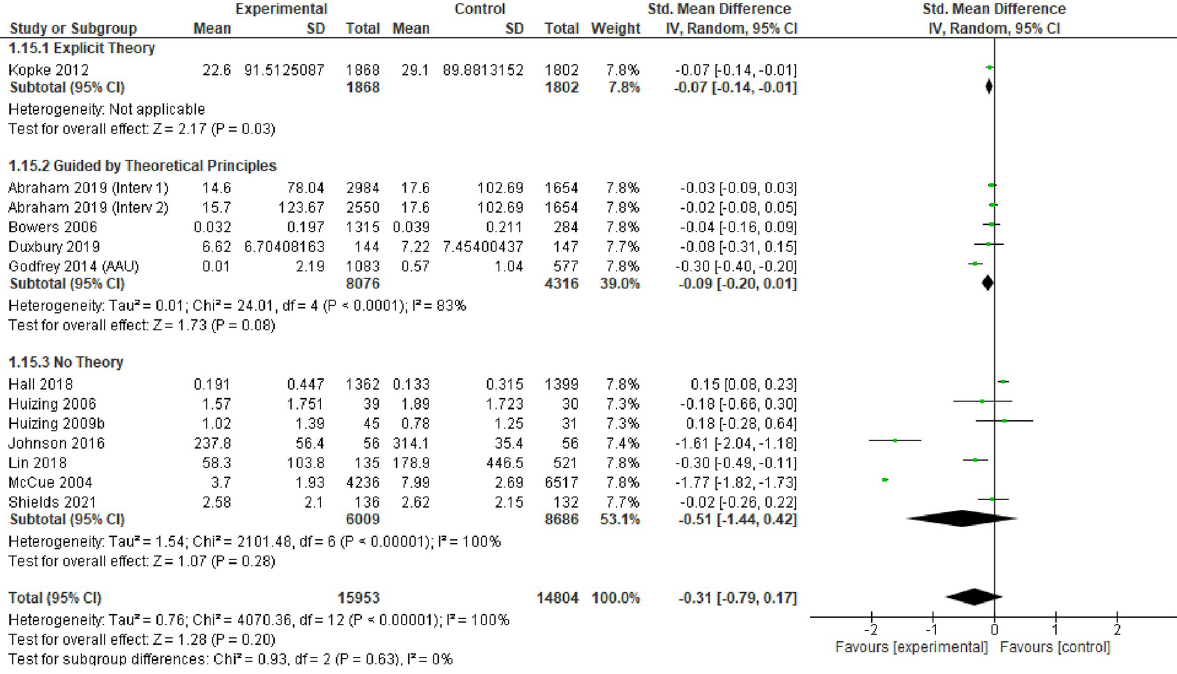
Fig 6. Effectiveness of interventions with an underpinning theory on the use of restraint, excluding outliers.